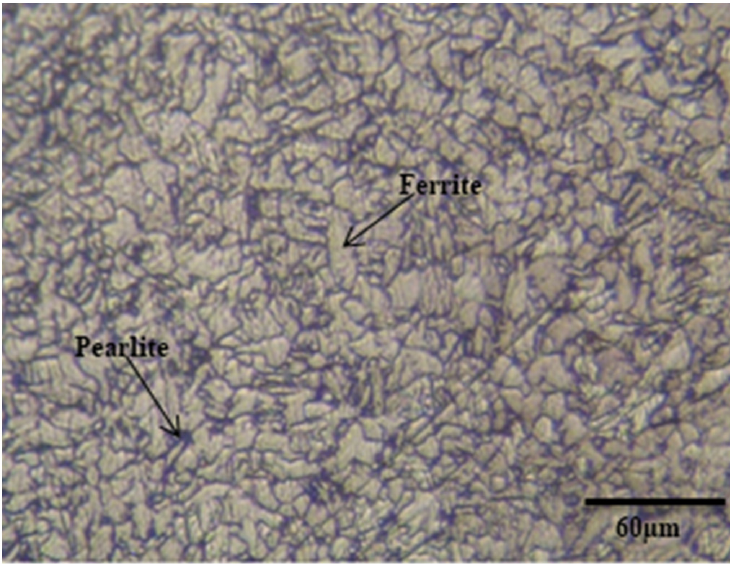
Figure 1. Microstructure of ASTM Steel A36.